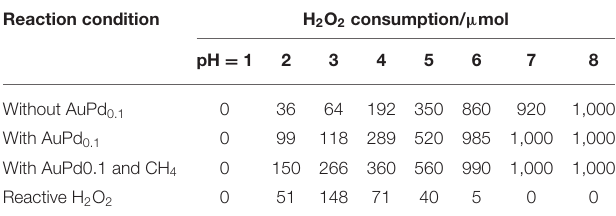
TABLE 1 | H 2 O 2 consumption with/without AuPd 0.1